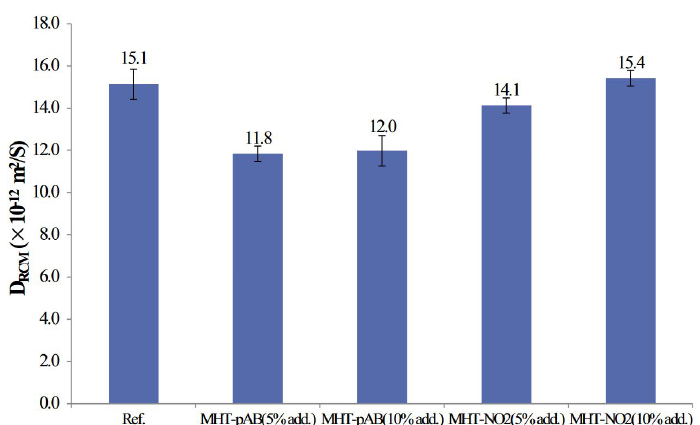
Figure 8. Chloride diffusion coefficients of mortar with 5% and 10% dosage of LDH. (Reprinted from [100], with permission from